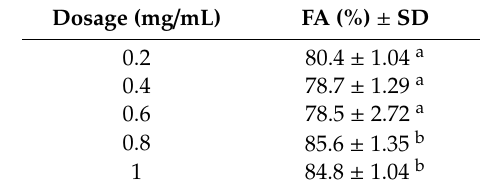
Figure 6. SEM analysis. SEM surface images of the bioflocculant ( left ), flocculated kaolin particles ( middle ) and kaolin particles ( right ). 3.12. Bioflocculant Composition Bioflocculants compose of polysaccharides, lipids, proteins, nucleic acids, and other polymeric compounds [53]. The bioflocculant (1 mg/mL) revealed to have high content of total carbohydrates (0.886 mg/mL) and low total protein content (0.095 mg/mL) (Table 3). The results were similar to those of Toeda and Kurane. [54]. Whereby the bioflocculant from Alcaligenes cupidus KT201 was mainly composed of carbohydrates. The composition of both carbohydrates and proteins suggested that the bioflocculant has multiple functional groups. Multiple functional groups are indicative for many adsorption sites for the colloidal particles and this can lead to high flocculating efficiency [55]. Carbohydrates derivatives in bioflocculant were, therefore, presumed to be the most responsible components for the experientially high flocculating activity as the bioflocculant is predominantly carbohydrates.